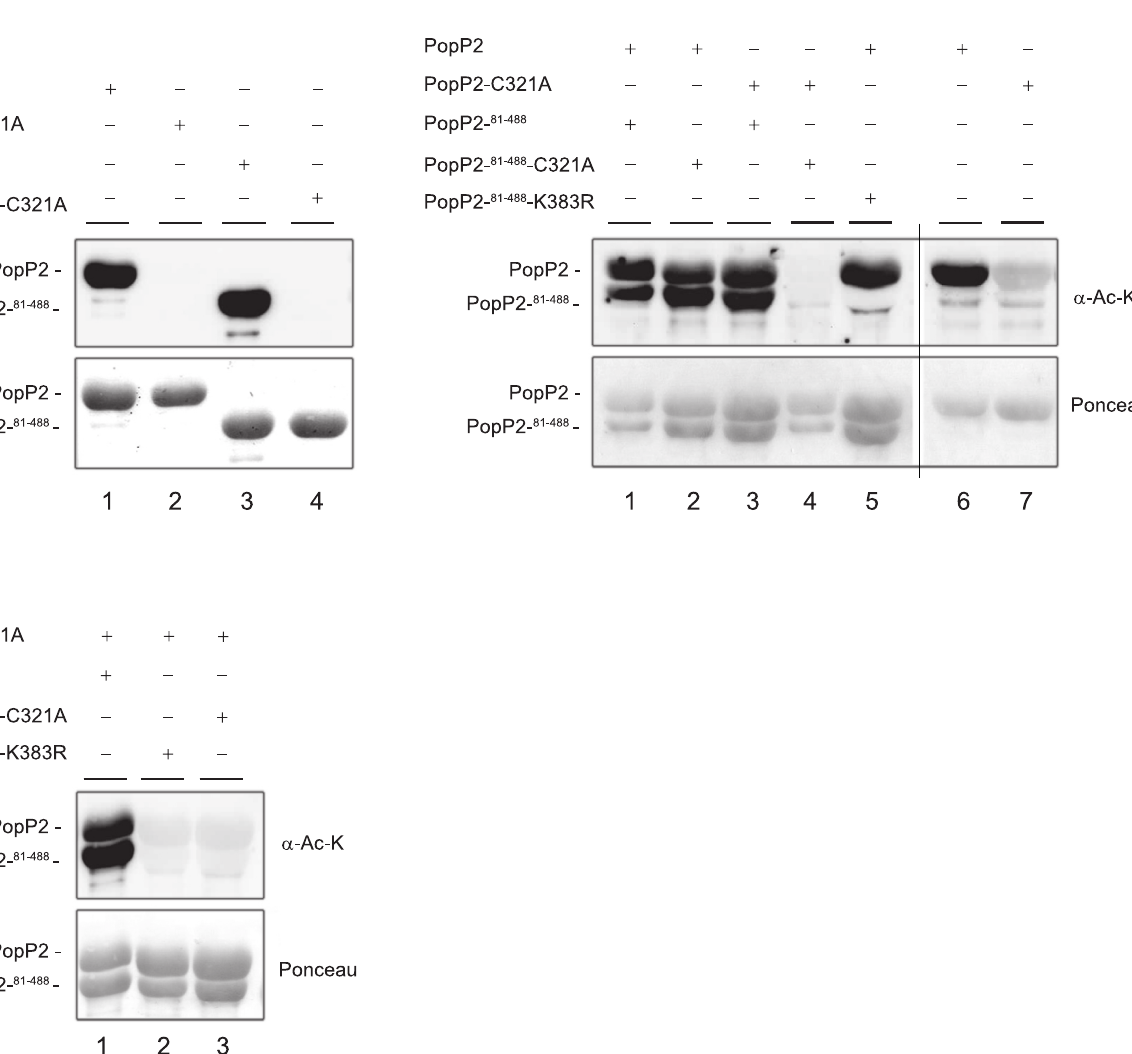
PLOS Pathogens| https://doi.org/10.1371/journal.ppat.1010368 March 2,